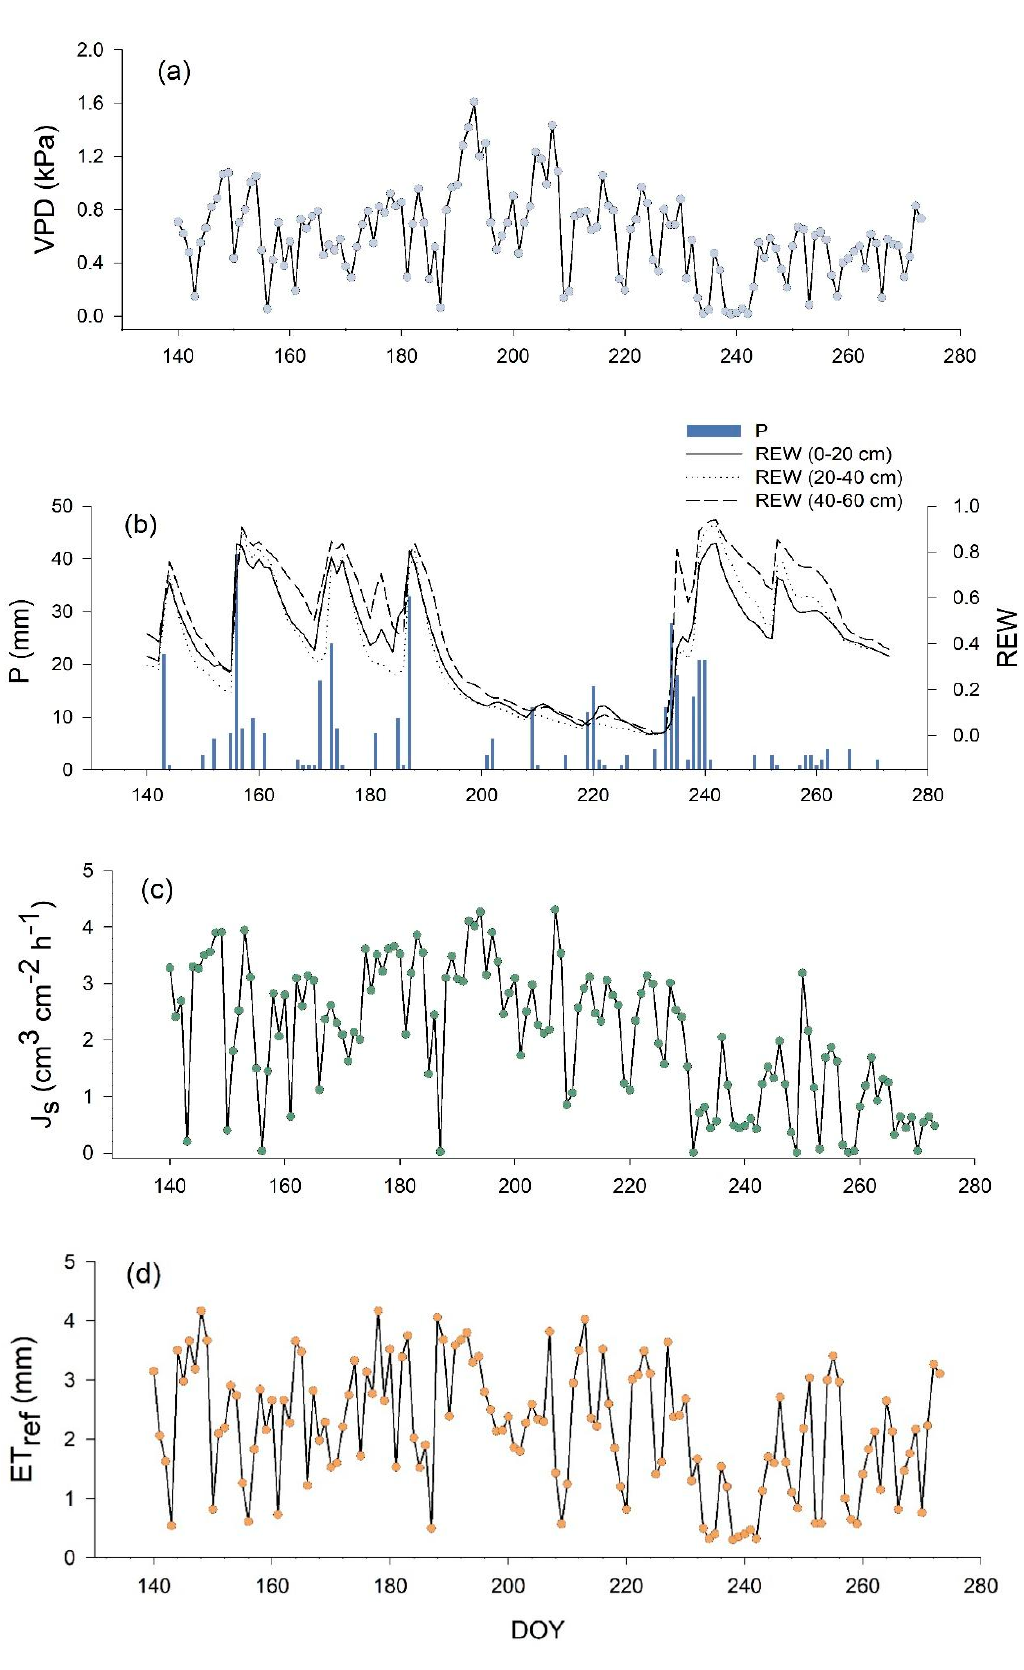
Figure 1. Variations in daily average sap flux density and environmental factors during the experimental period: ( a ) Vapor pressure deficit (VPD); ( b ) precipitation (P) and relative extractable water (REW); ( c ) sap flux density (J s ); and ( d ) reference crop evapotranspiration (ET ref ). DOY refers to the day of the